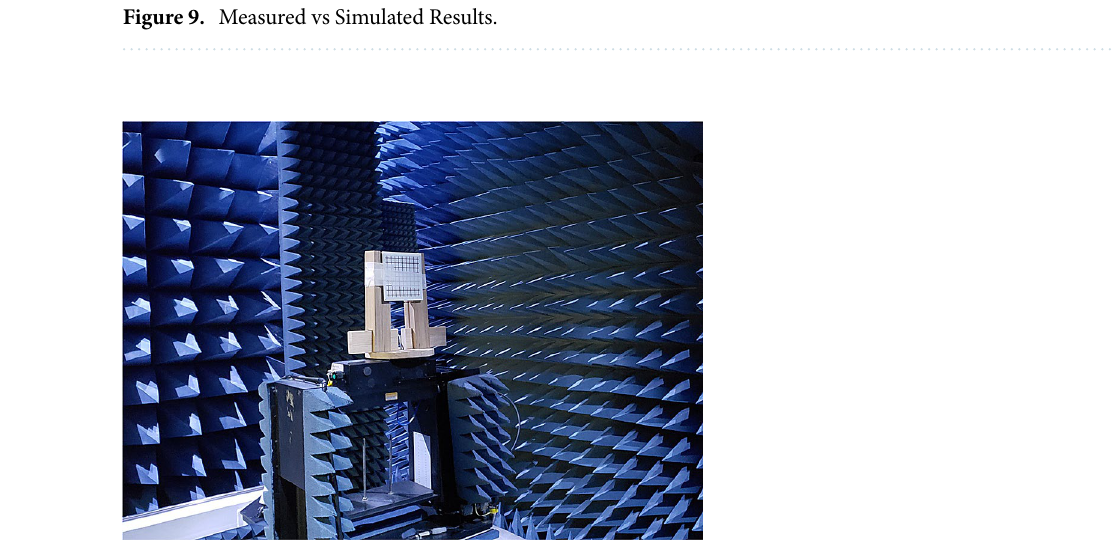
Figure 10. Measurement